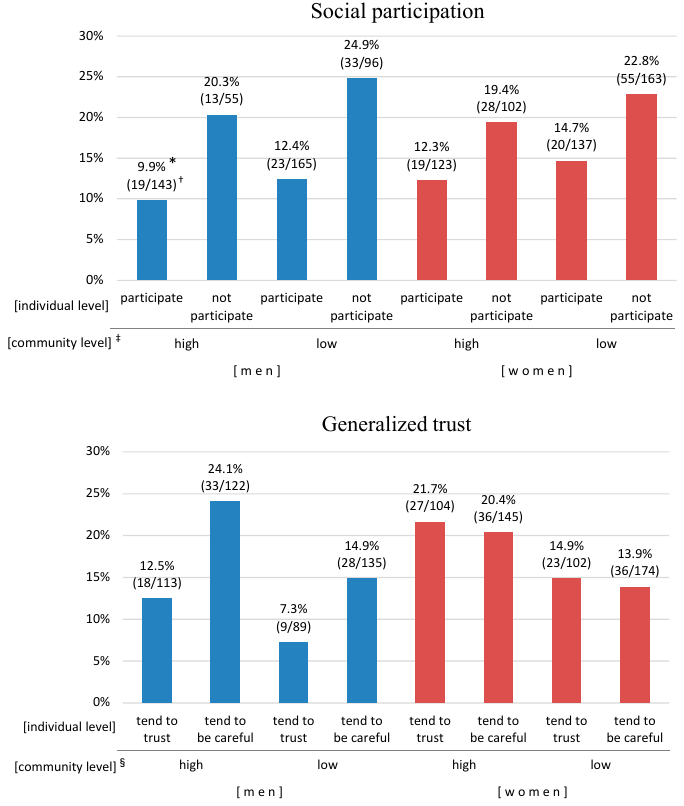
Figure 2. Relationship of community level and individual level social capital to composite outcome by gender. * Adjusted probability from the fixed effects only of composite outcome for each category by gender stratified multilevel logistic analyses after adjusting for all covariates; † Number of outcomes/analyzed population; ‡ High: area B, C, D, E. Low: area A, F, G, H; § High: area C, D, F, H. Low: area A, B, E, G.